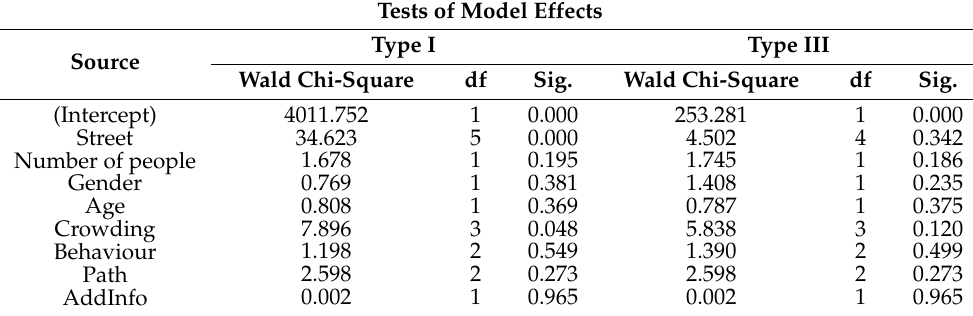
Table 1. Tests of model